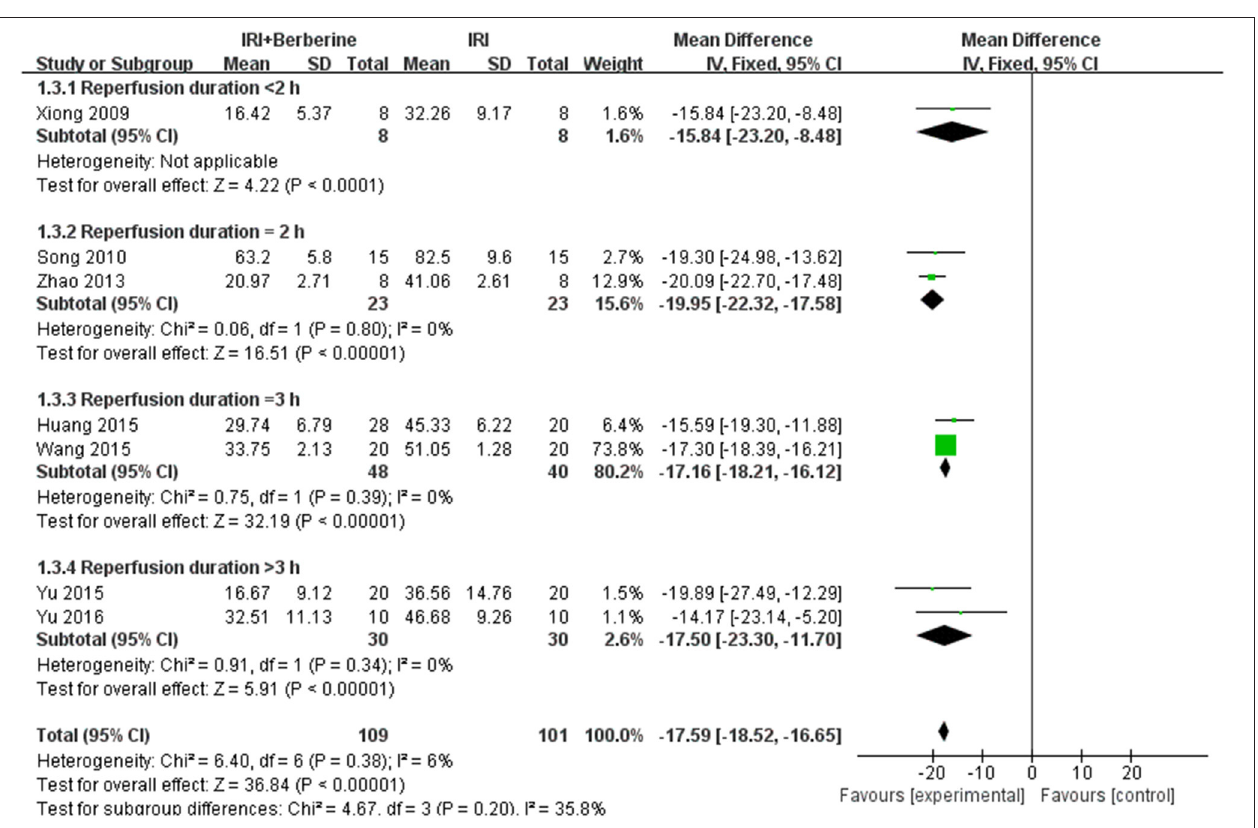
increased LVFS compared to the control groups [ n = 124, MD = 12.21, 95% CI (10.27, 14.15), P < 0.00001, I 2 = 0%] ( Figure 6